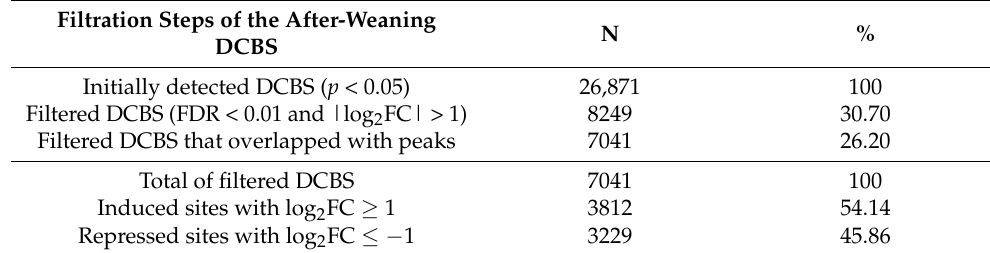
Table 3. Number of differentially CTCF-binding sites (DCBS) after weaning showing the different steps of filtration, including the number of induced and repressed sites. Filtration Steps of the After-Weaning DCBS